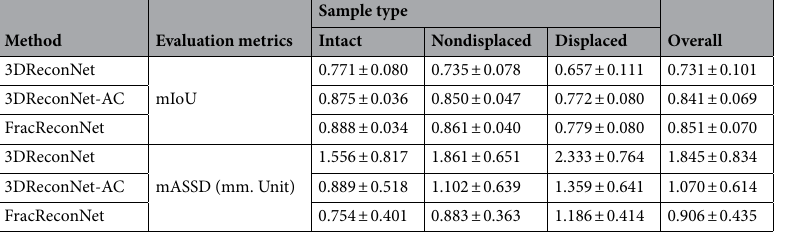
Table 2. The quantitative results of the study on the proposed method of various networks. It includes 3DReconNet, 3DReconNet-AC and FracReconNet. Mean of the mIoU and mASSD values (mean ± SD) are used as the comparison